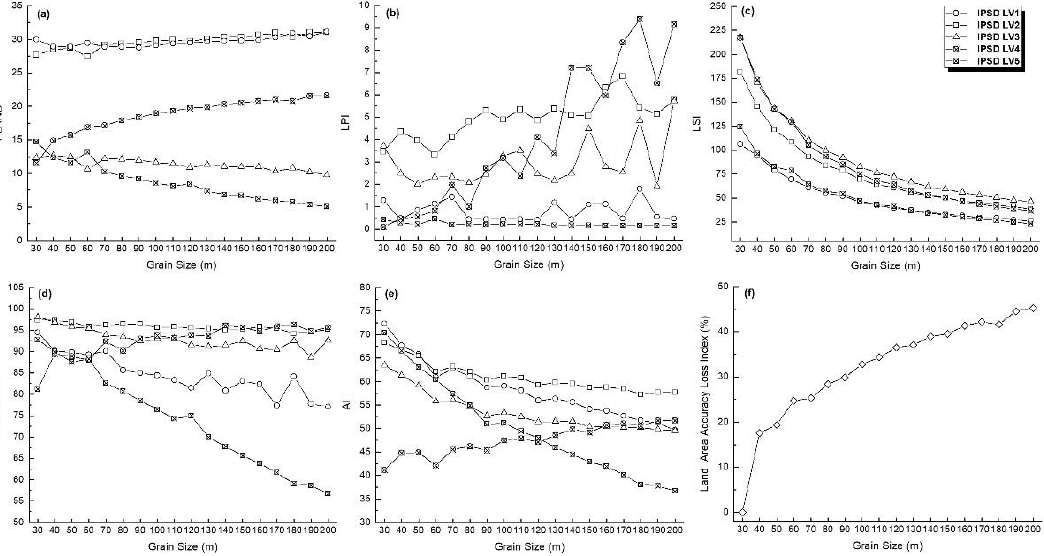
Figure 3. Response curves of class level metrics ( a – e ) and land area accuracy loss ( f ) to the grain size variation.